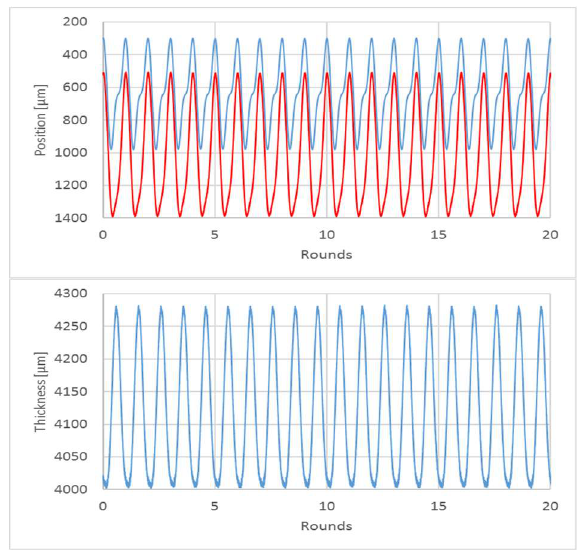
Fig. 2. Top: Signal of the front (blue) and back (red) surface of the disc over 20 rotations, measured from one side of the disc. The signal of the back surface (lower trace) was shifted to be visible on the same scale. Bottom: Thickness of the disc calculated from the signals of both surfaces.